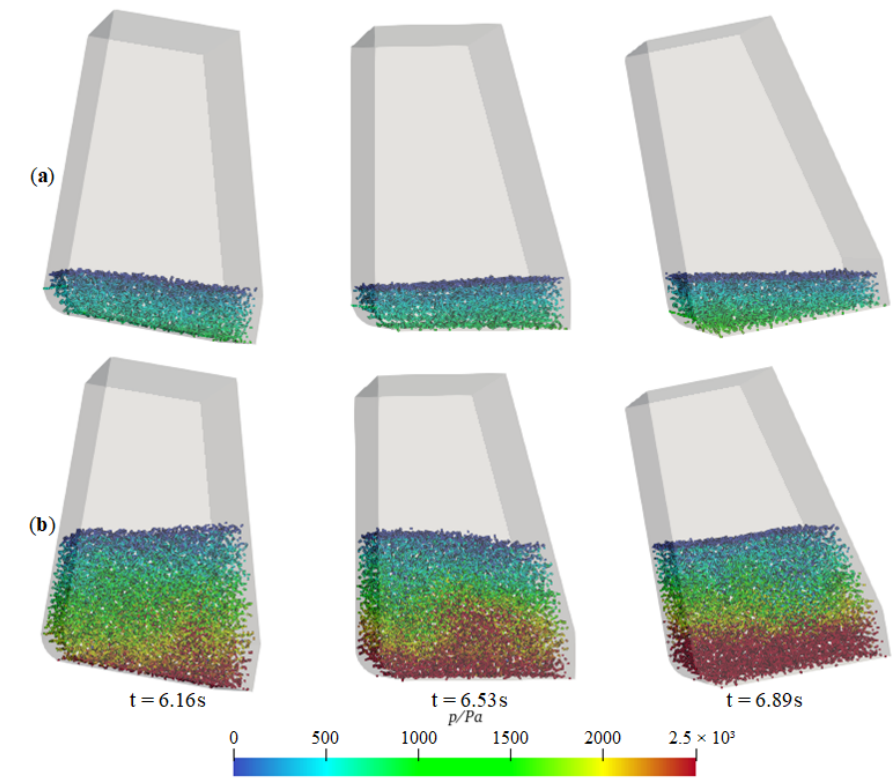
Figure 7. Snapshots of flow field in different filling ratios. ( a ) case 1; ( b ) case 2.